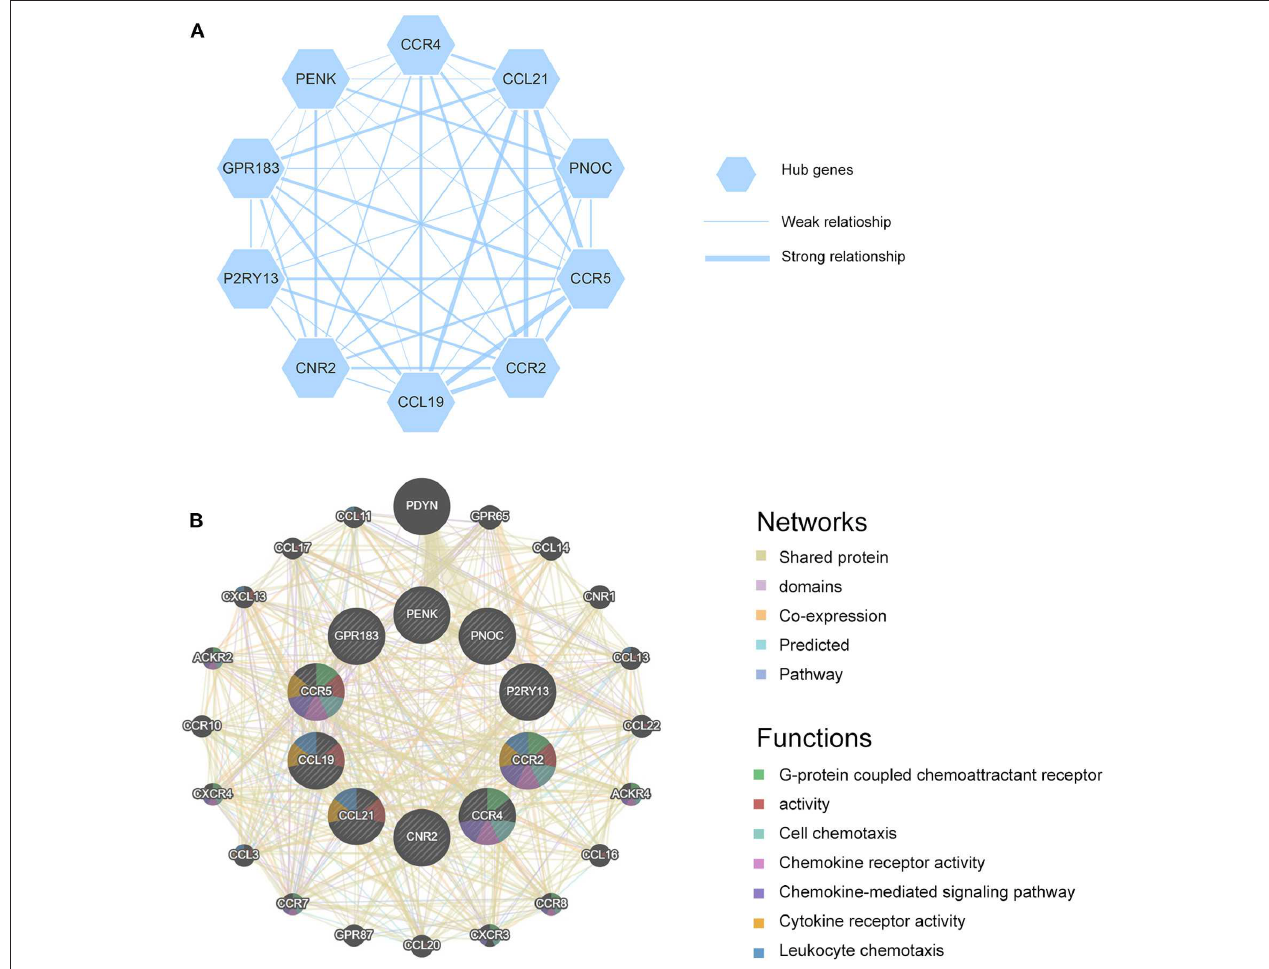
FIGURE 4 | (A) Hub genes are shown and the thickness of the line indicates the extent of the relationship between two genes. (B) GeneMANIA is used to identify predicted genes correlating with hub genes, 20 of the predicted genes are located in the outer circle while hub genes are drawn in the inner circle. The color of the line illustrates different type of their relationships. The color inside the gene dots indicates functions which these genes are involved in.